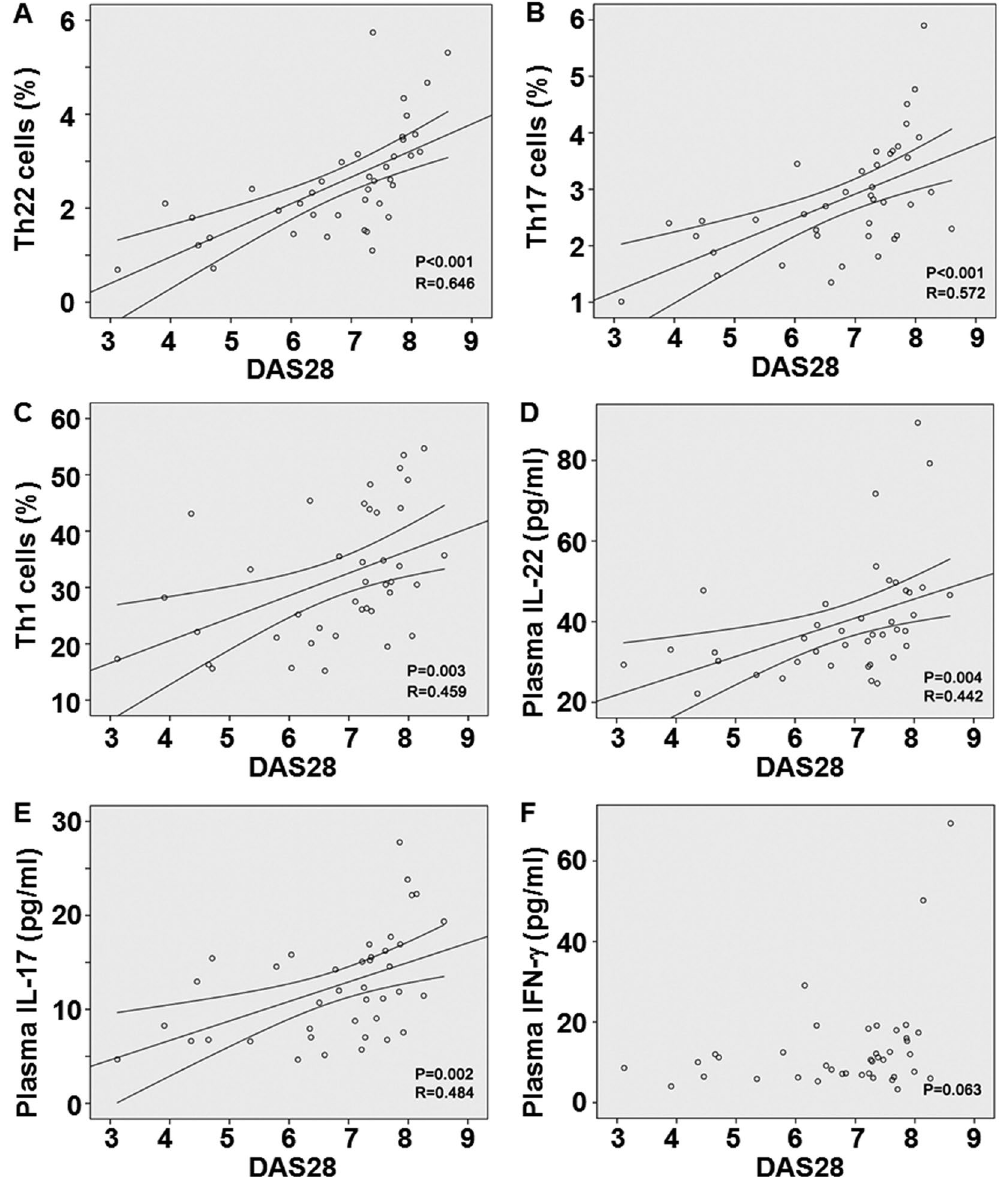
Figure 6. Correlation of T helper cell subsets or their main cytokines in bone marrow with Disease Activity Score in 28 joints. Correlation of ( A ) Th22, ( B ) Th17, ( C ) Th1, ( D ) plasma IL-22 concentration, ( E ) plasma IL-17 concentration, and ( F ) plasma IFN- γ concentration with Disease Activity Score in 28